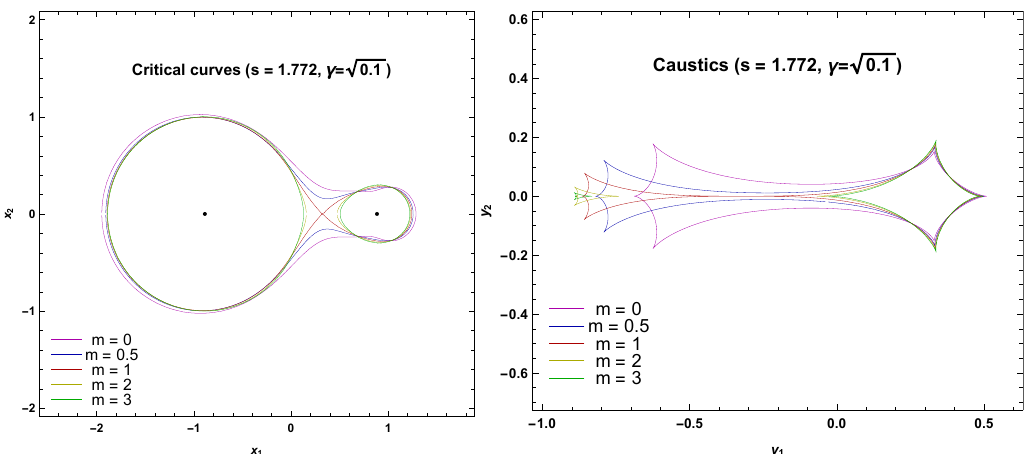
Figure 8. Critical curves and caustics in the unequal-strength binary, intermediate-wide